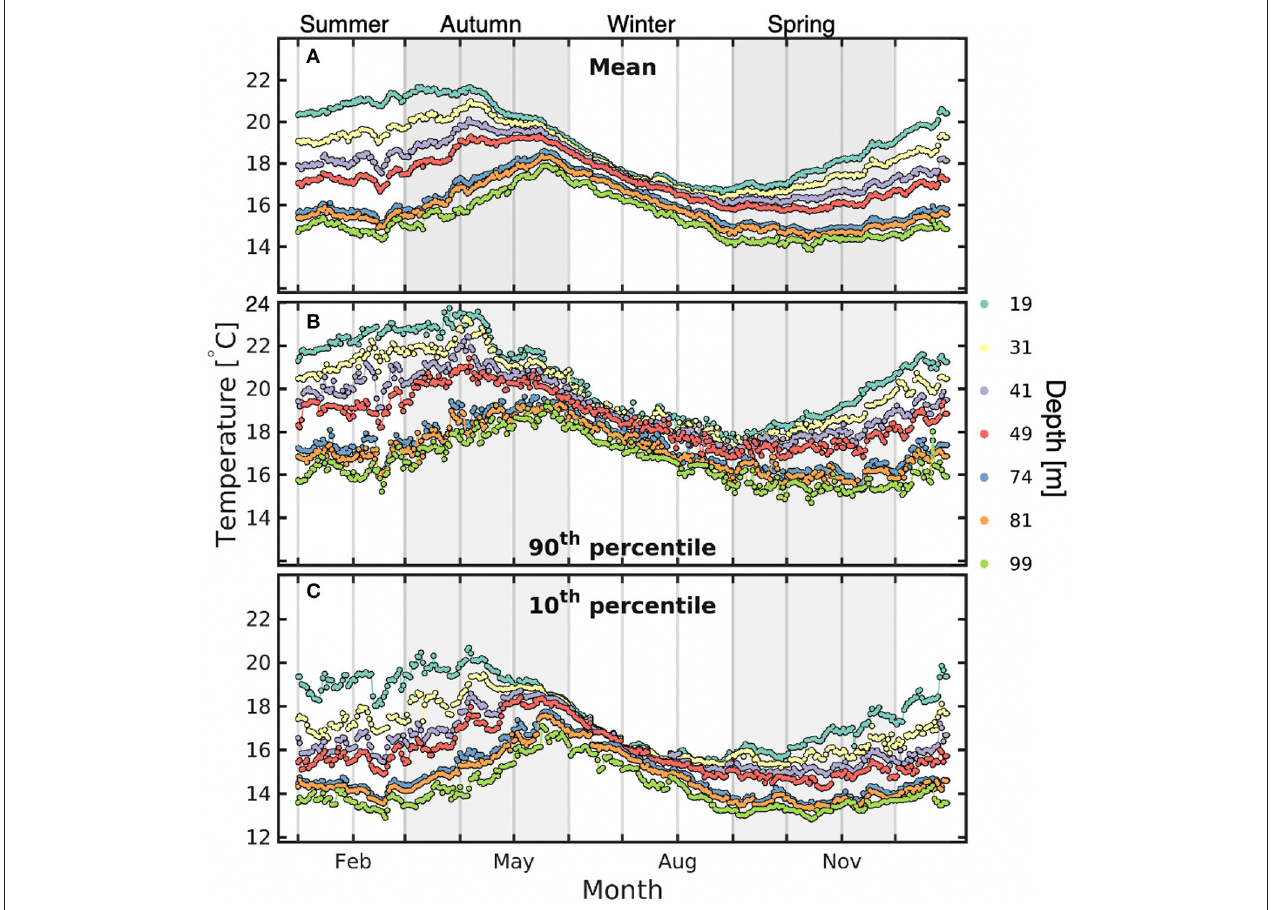
FIGURE 9 | The climatology (A) means, (B) 90th and (C) 10th percentiles for each optimal depth level: 19, 31, 41, 49, 74, 81, and 99m. The alternating gray shading present in time-depth plot space in each subpanel represents the different seasons, labeled at the top of panel (A)